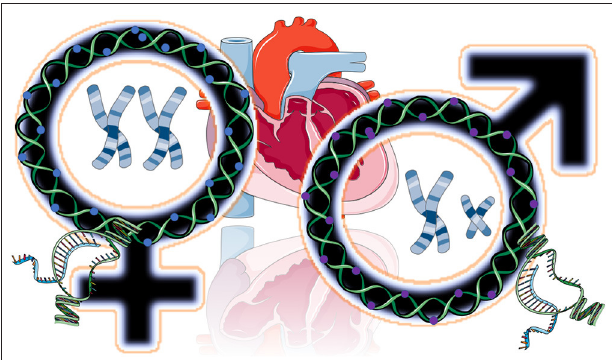
FIGURE 1 | Illustrative figure of the sex differences in cardiovascular genetics.